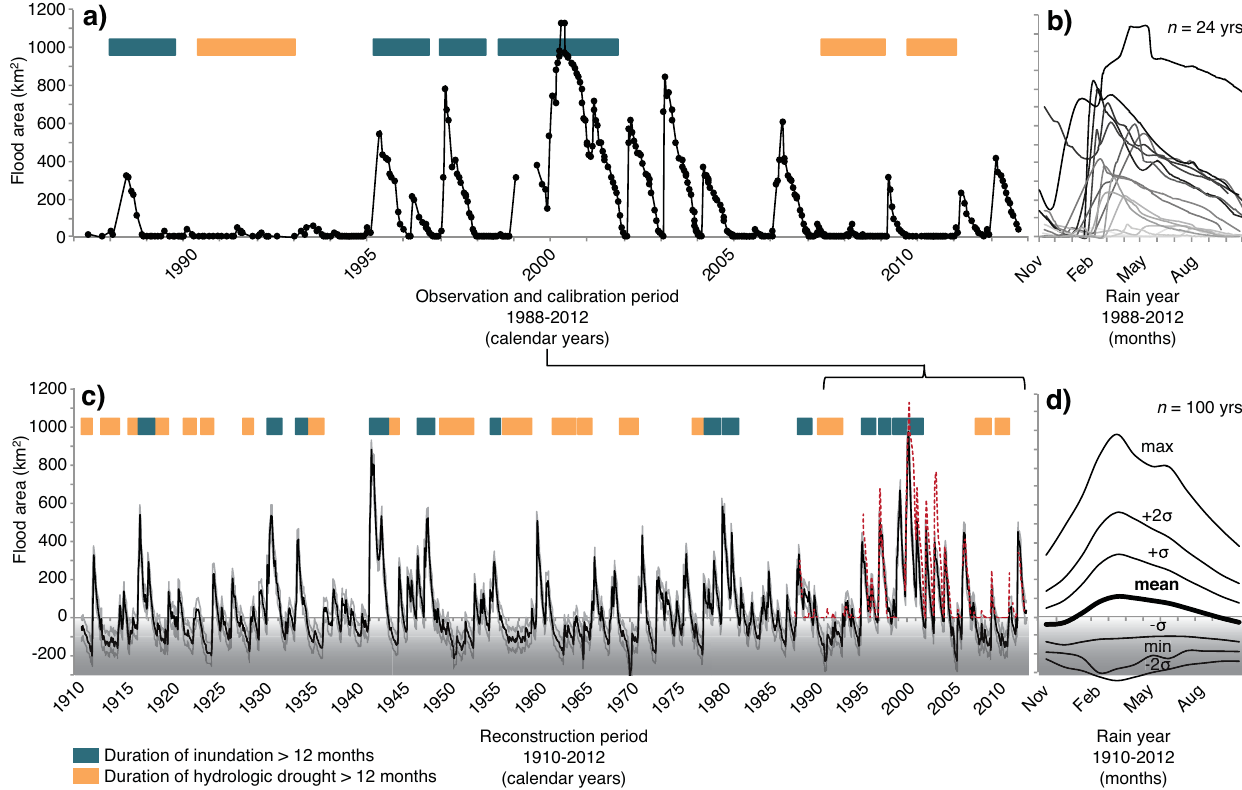
Figure 3. 1988–2012 (a) flood area observation and calibration data set (solid black line with dots for each observation) and its (b) tim- ing of seasonal change over the rain year ( n = 24 years); 1912–2012 (c) flood area reconstruction (solid black line), monthly E RMSP of (cid:49)F A =± 56km 2 (solid grey lines) and observation data set plotted for the 1988–2012 period (red dashed line) for comparison and (d) monthly mean, minimum (min), maximum (max) and 1 σ and 2 σ ranges of variation over the rain year for the reconstructed period ( n = 100 years). Overlaid on (a) and (c) time series are the supra-seasonal dry and wet periods, where F A was either < 0km 2 or > 0km 2 for over 12 consecutive months. (c, d) F A ≤ 0km 2 : no surface water evident on the Marsh